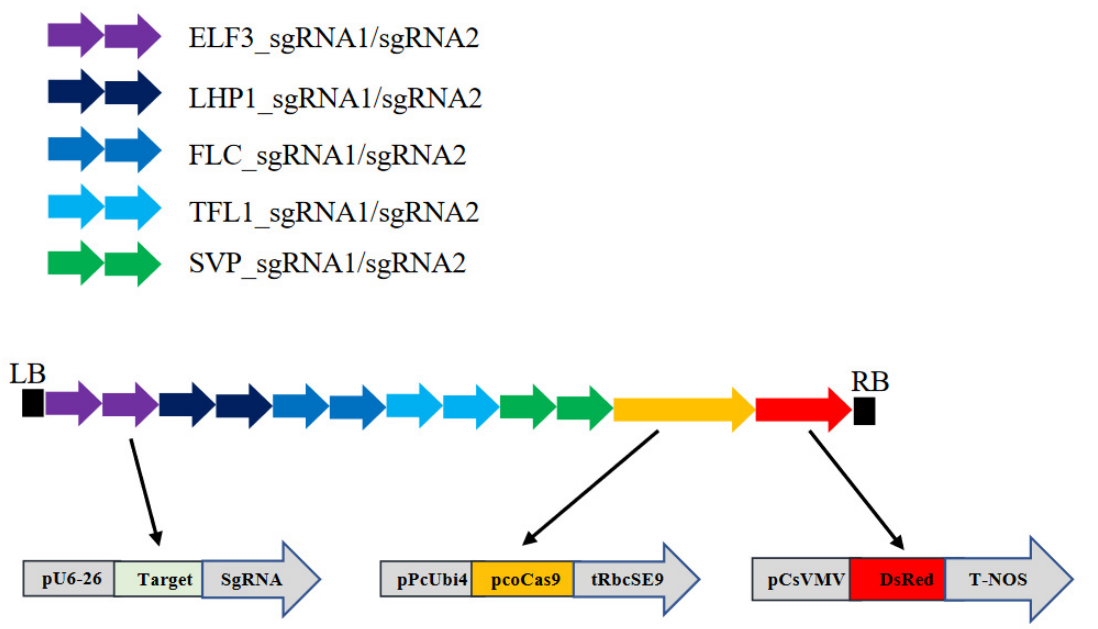
Figure 1. Organization of the T-DNA used to CRISPR/Cas9 mutagenize camelina via Agrobacterium floral dip. LB and RB represent the left and right borders of the T-DNA, between which are shown, from left to right, the ten genes encoding sgRNAs, the pcoCas9 gene, and the DsRed marker gene.